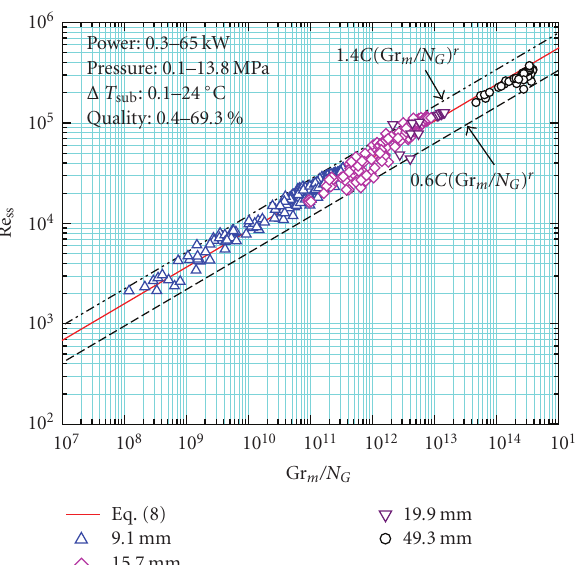
Figure 9: Comparison of steady state data with correlations.